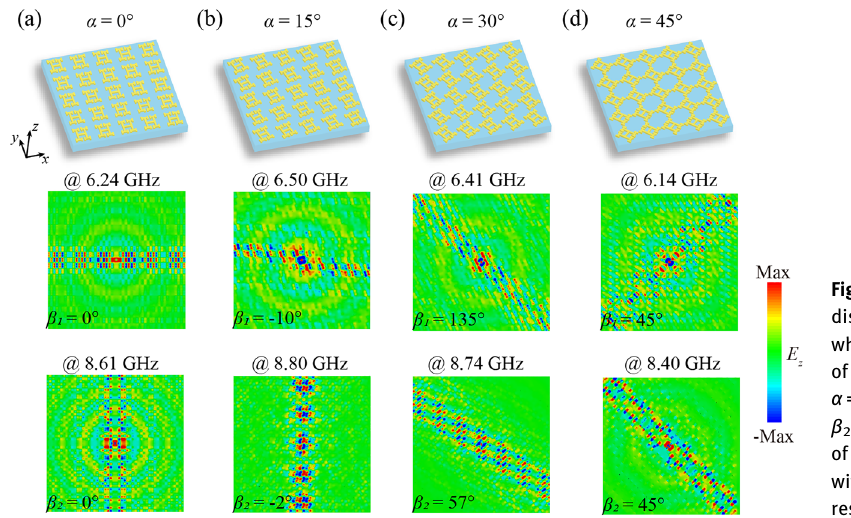
choose the unit cell with α = 45 ° and α = 135 ° as theprimitive cells for the following model.